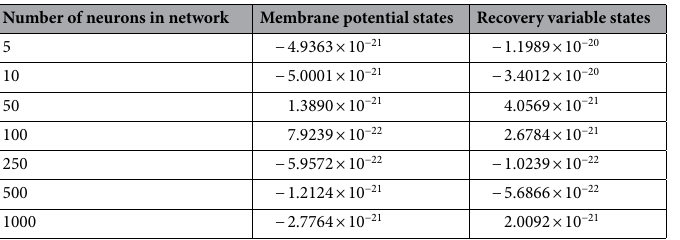
Table 5. Mean errors in the synchronization dynamics of the membrane potential states and recovery variable states for different-sized bidirectional networks of FHN neurons with noise.